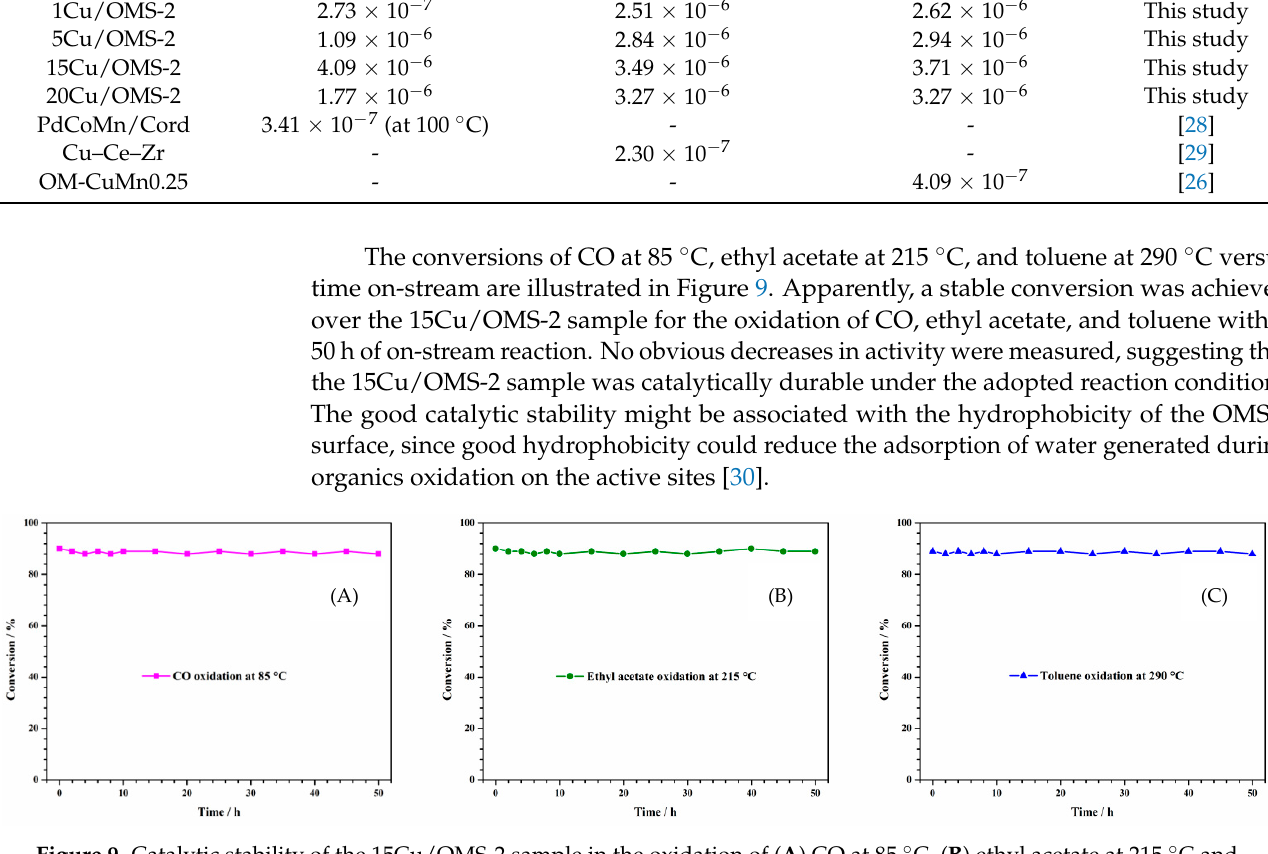
Figure 9. Catalytic stability of the 15Cu/OMS-2 sample in the oxidation of ( A ) CO at 85 ◦ C, ( B ) ethyl acetate at 215 ◦ C and ( C ) toluene at 290 ◦ C.